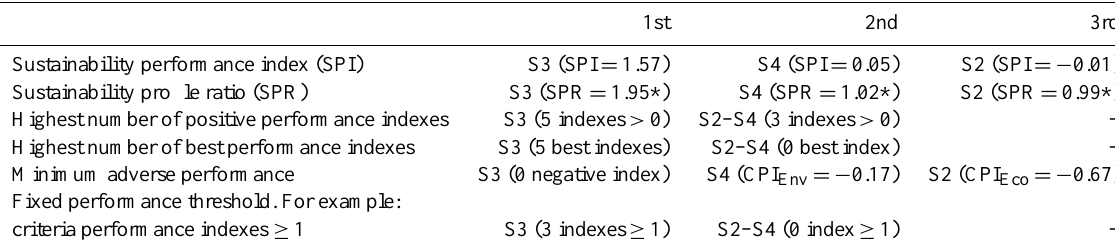
Table 9. Options ranking based on the decision rules (using a nine-point